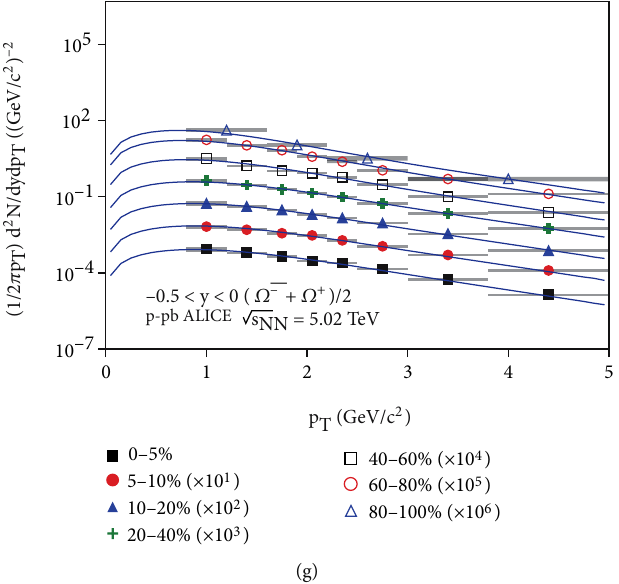
K + + K − , (b) ð K ∗ 0 + (cid:1) K ∗ 0 Þ /2 , (c) K 0 Figure 3: The p T spectra of (a) p ffiffiffiffiffiffiffi = 5 : 02 TeV. The symbols represent the data measured by the ALICE Collaboration [44, 45]. The solid curves represent the Monte s at NN Carlo results, based on the probability density function Equation (2) and the p T expression in Equation